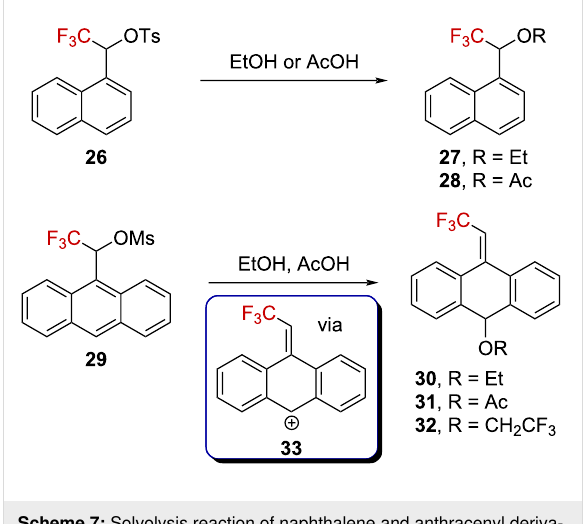
A different behavior emerged from triflate derivatives